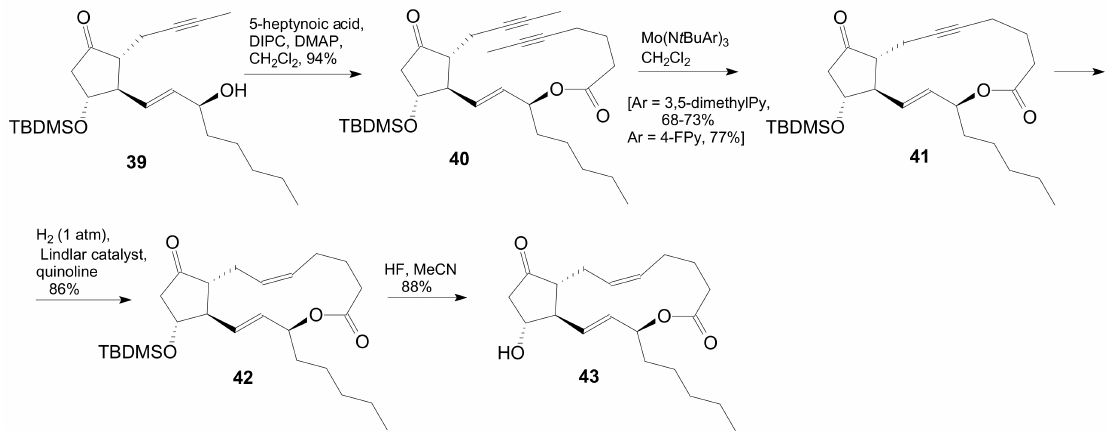
Scheme 8. Synthesis of PGE 2 -1,15-lactone by RCM.